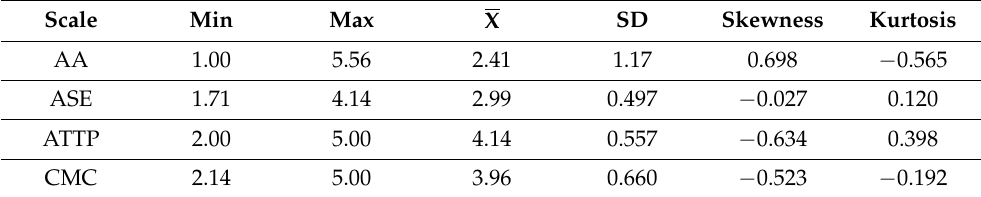
Table 4. Mean, standard deviation, skewness, and kurtosis values of the scales (N =